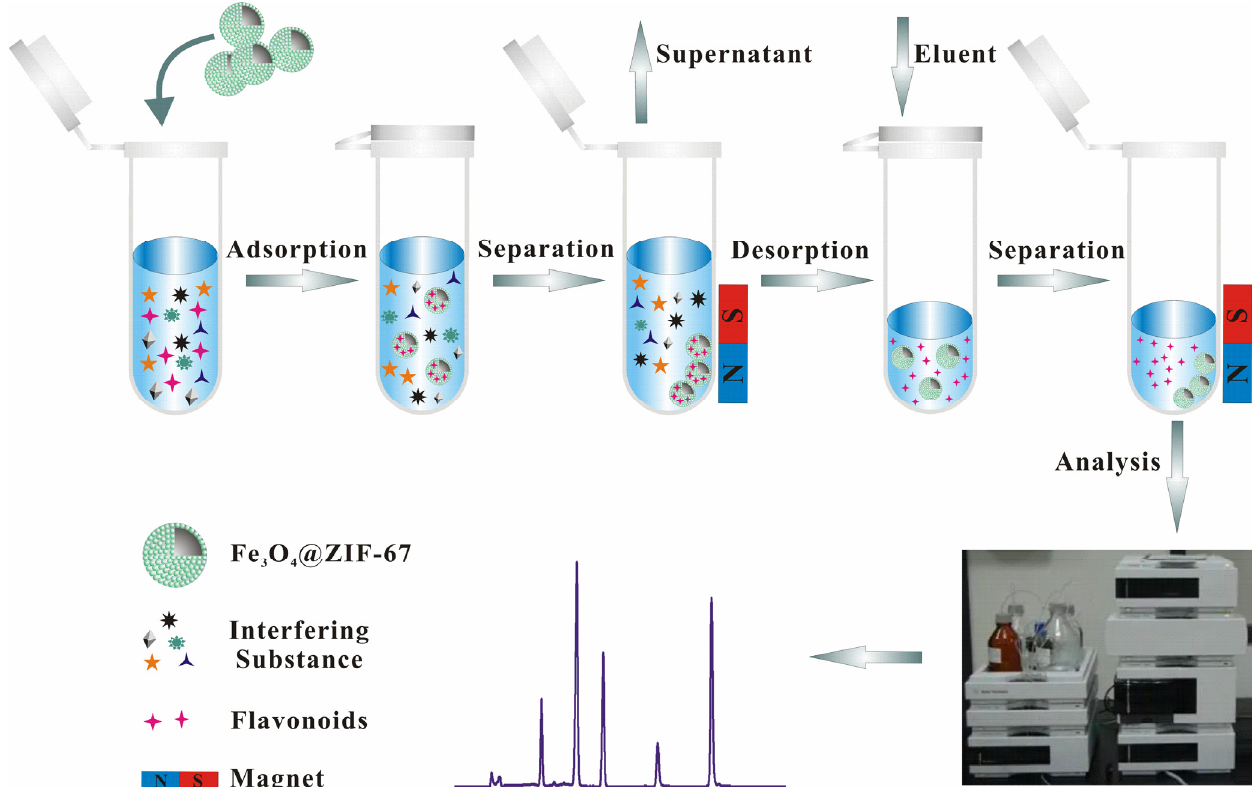
Figure 6. Schematic illustration of the procedure of Fe 3 O 4 @ZIF − 67-based MSPE.